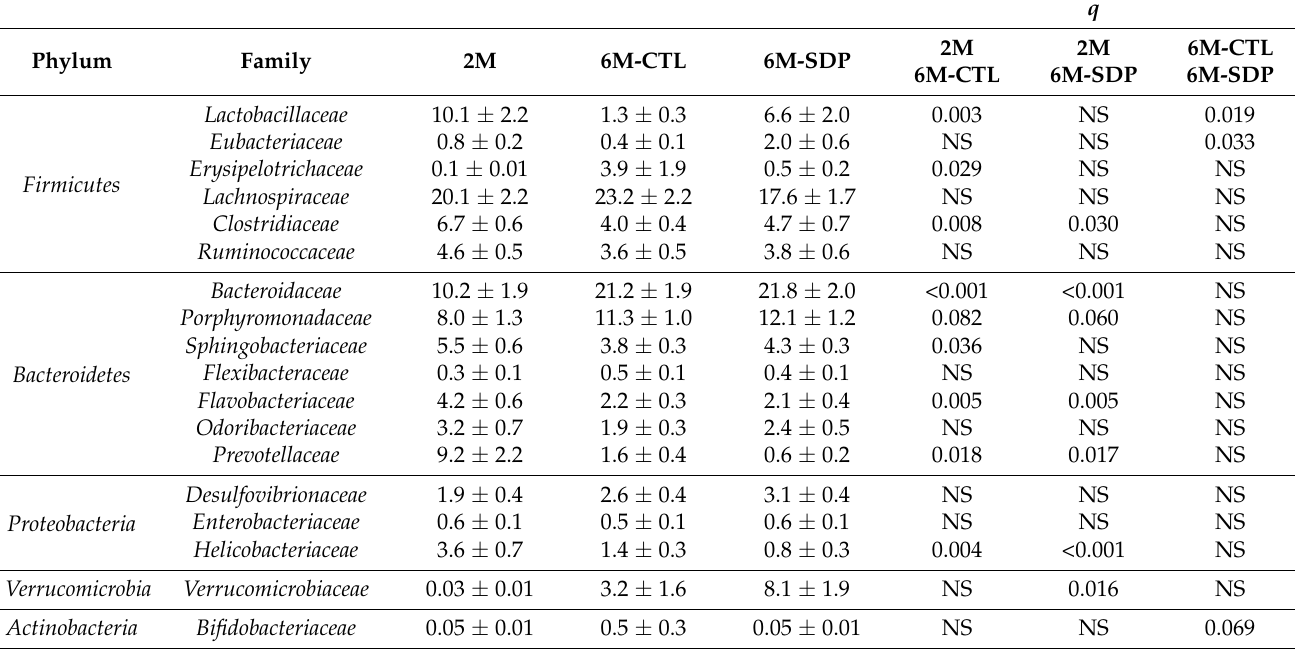
Table 1. Bacterial composition at family